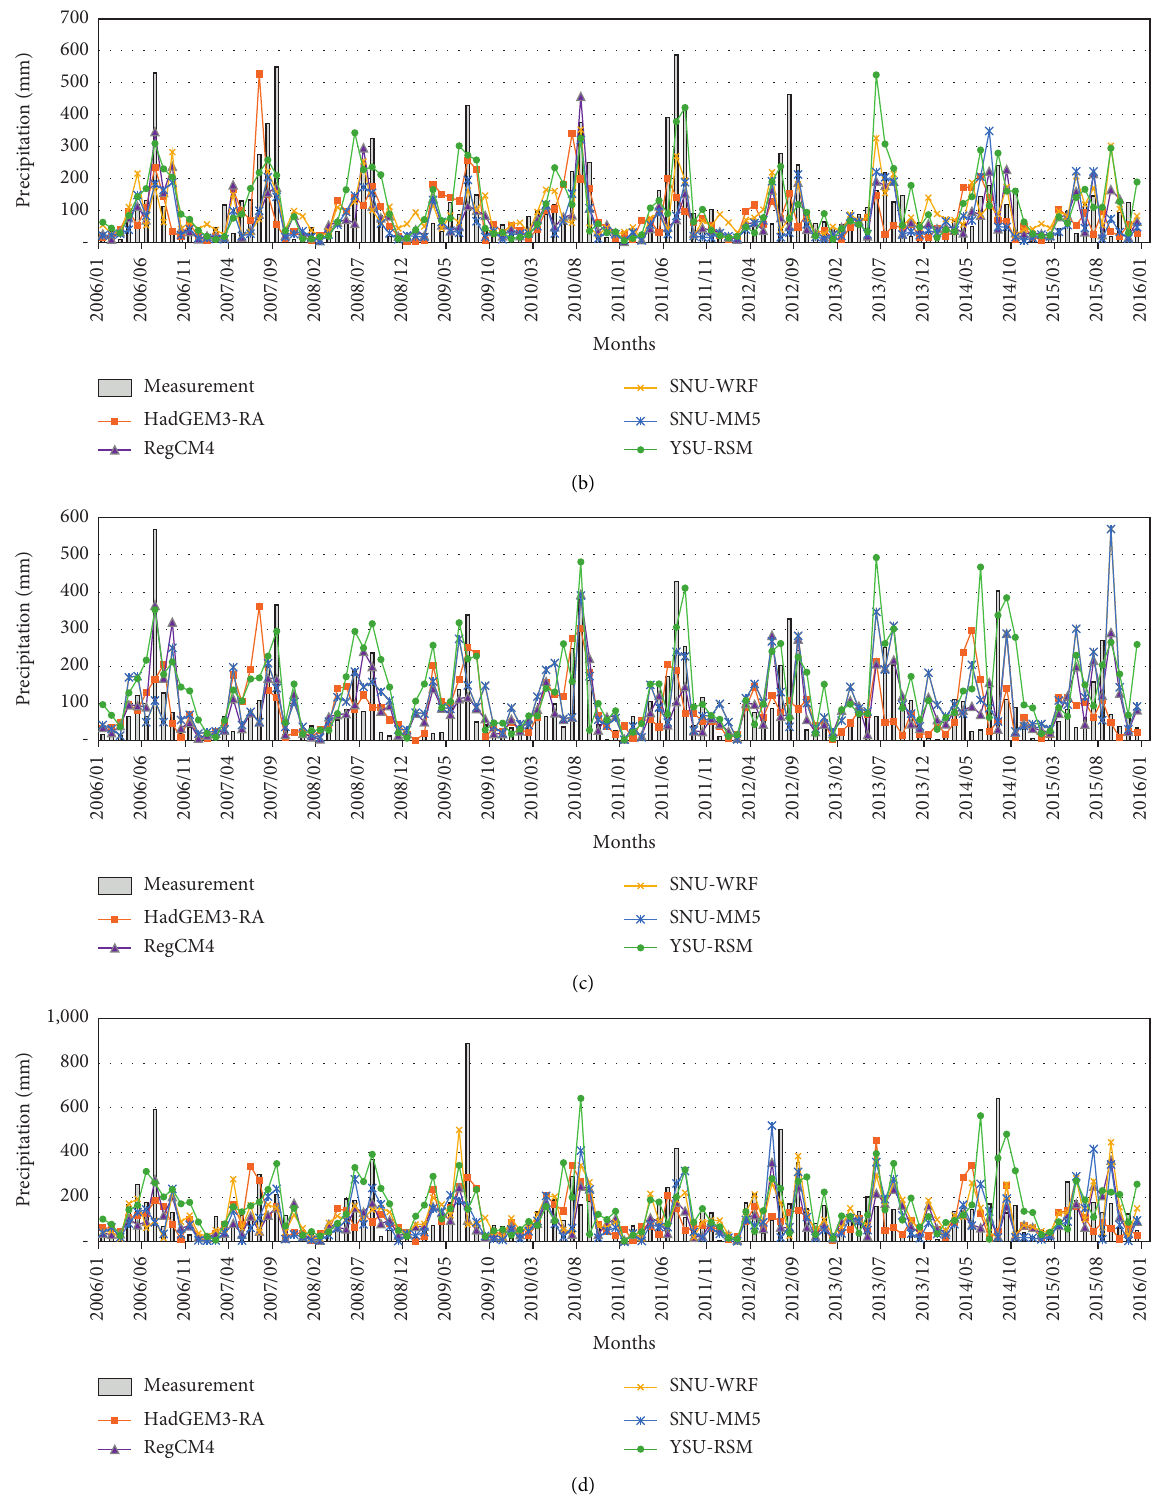
Figure 3: Monthly precipitation graph from RCMs and observatory of 4 major cities: (a) Seoul, (b) Daejeon, (c) Daegu, and (d)